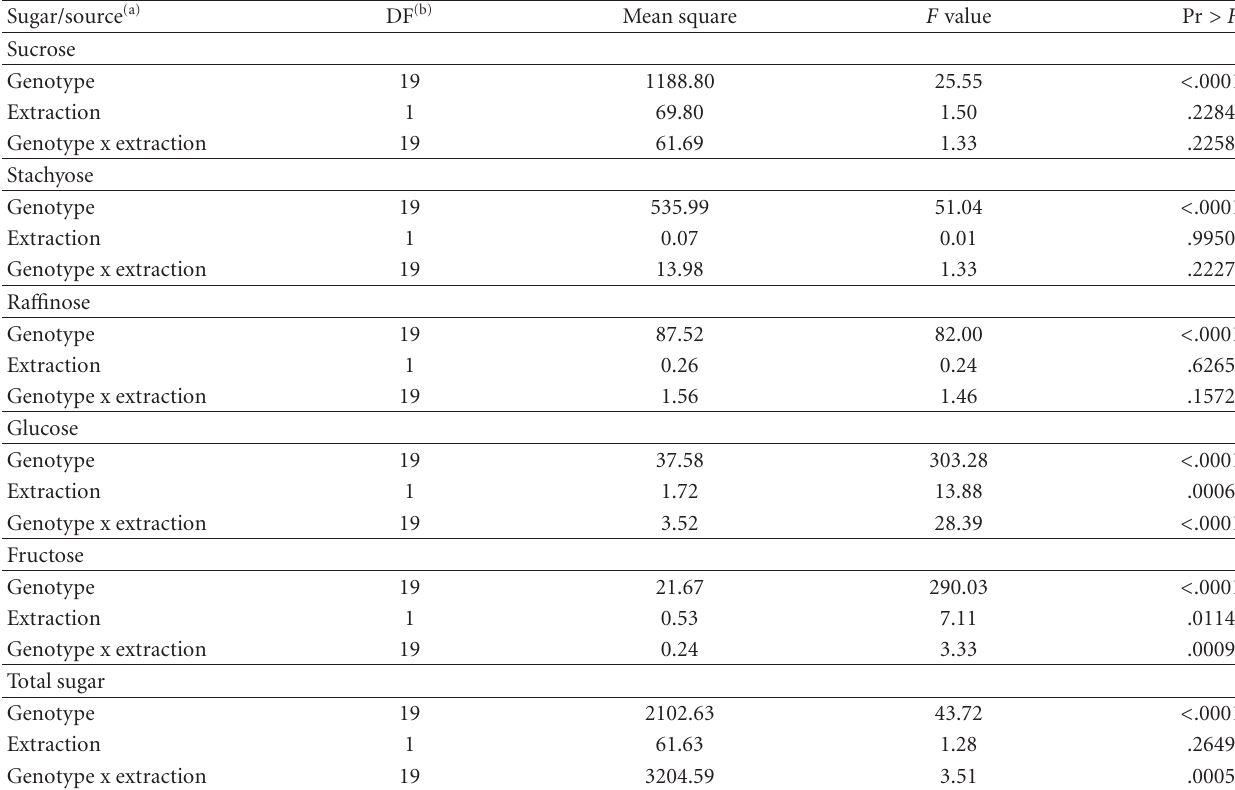
Table 2: Analyses of variance for five major sugar and total sugar contents in twenty soybean genotypes.